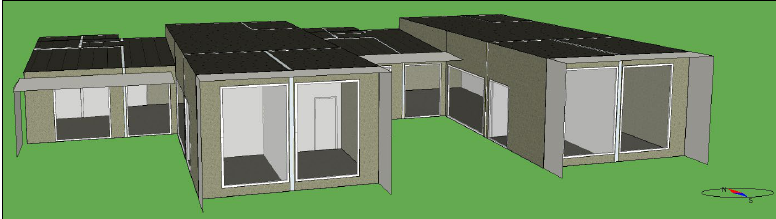
Fig. 2. Rendering of the simulation